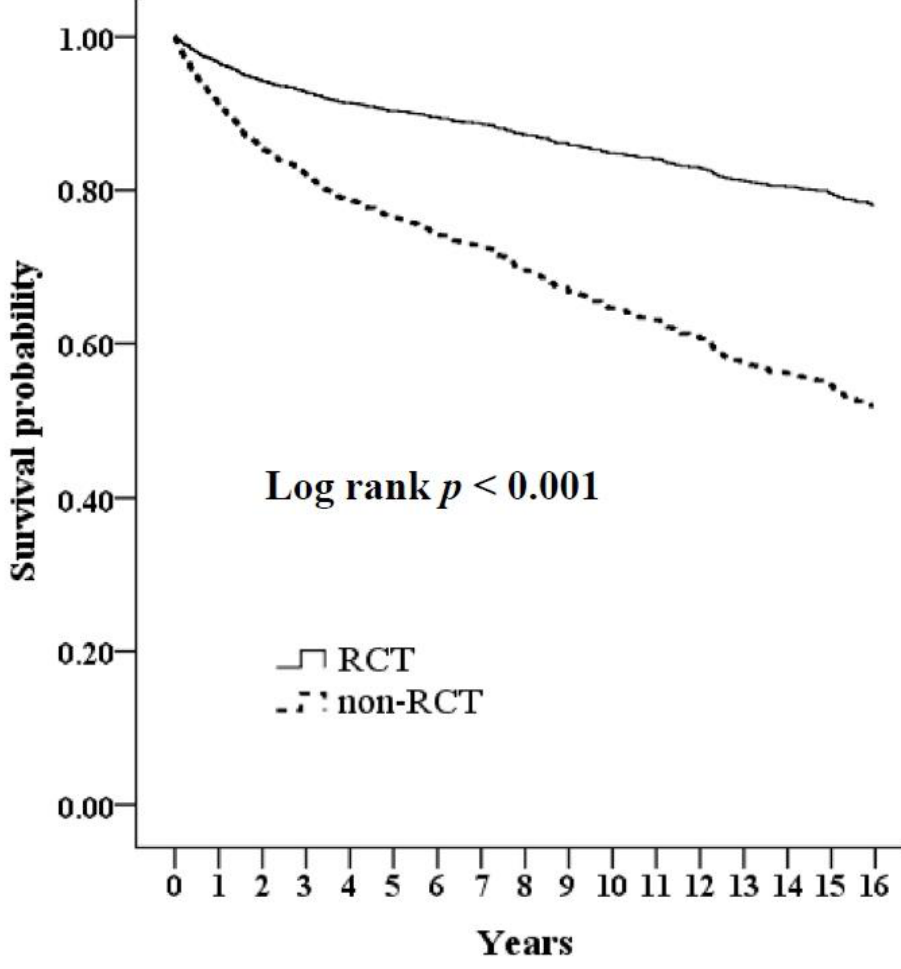
Figure 2. Cumulative survival in dialysis patients with RCT compared to without RCT. The cohort study was followed up for 16 years.